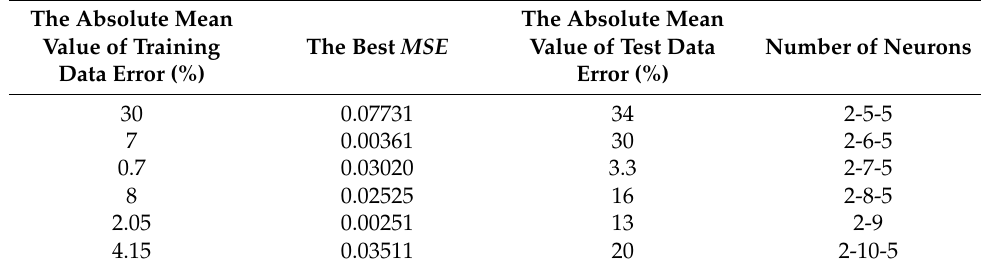
Table 1. Comparison of MSE value of networks with the different number of hidden layer neurons.